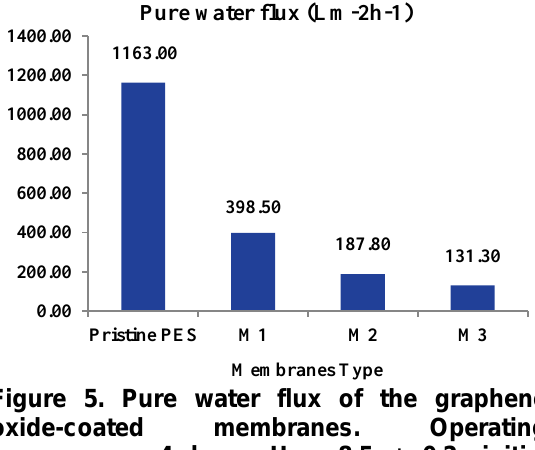
Pristine PES M3 Membranes Type Figure 5. Pure water flux of the graphene oxide-coated membranes. Operating pressures = 4 bar, pH = 8.5 ± 0.2, initial arsenate concentrations = 1000 ± 20 µg/l, feed temperature = 25 ± 0.5 Cº PES: Polyethersulfone